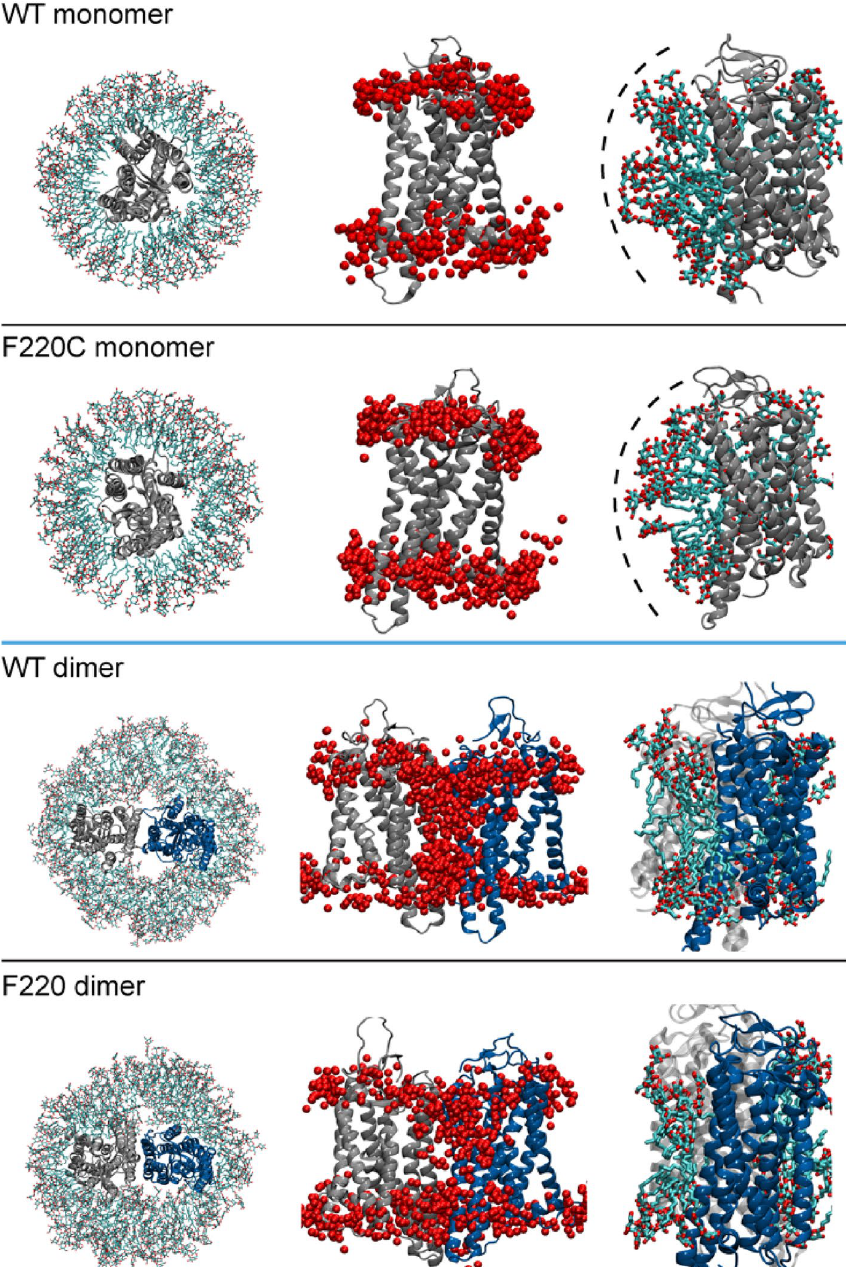
Figure 2. Structure of WT and F220C opsin monomers and dimers revealed by MD simulation. WT and F220C opsin monomers (top two rows) and dimers (bottom two rows) in DDM micelles. The snapshots on the left side of all rows show initial conformations of the respective systems: detergent molecules are shown as sticks, the protein is shown with its extracellular side on top (the monomer protein (tope two rows) is in grey, and the two protomers of the dimer constructs (bottom two rows) are in grey and blue). The middle panels show a side-view overlaid with locations of the O5 oxygen atom of the DDM headgroup (red spheres) that were within 4 Å of the protein at least in one frame of the respective trajectory. The right panels show close up views of the protein constructs highlighting arrangement of the detergent molecules around TM5 and TM6 helices. Note, that DDM molecules organize around monomeric WT and F220C opsins with their hydrophobic tails directed towards the protein (the dashed arcs trace the curved surface defined by the detergent headgroups). However, in the dimeric constructs they align vertically, akin to